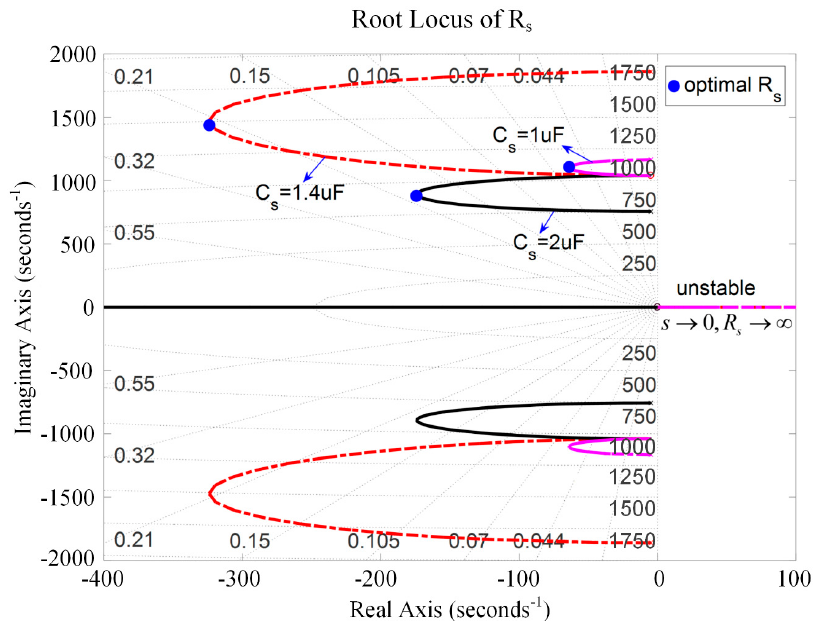
Figure 12. Root locus of the piezoelectric stack transducer with respect to R s for the negative capacitance in series with R s .